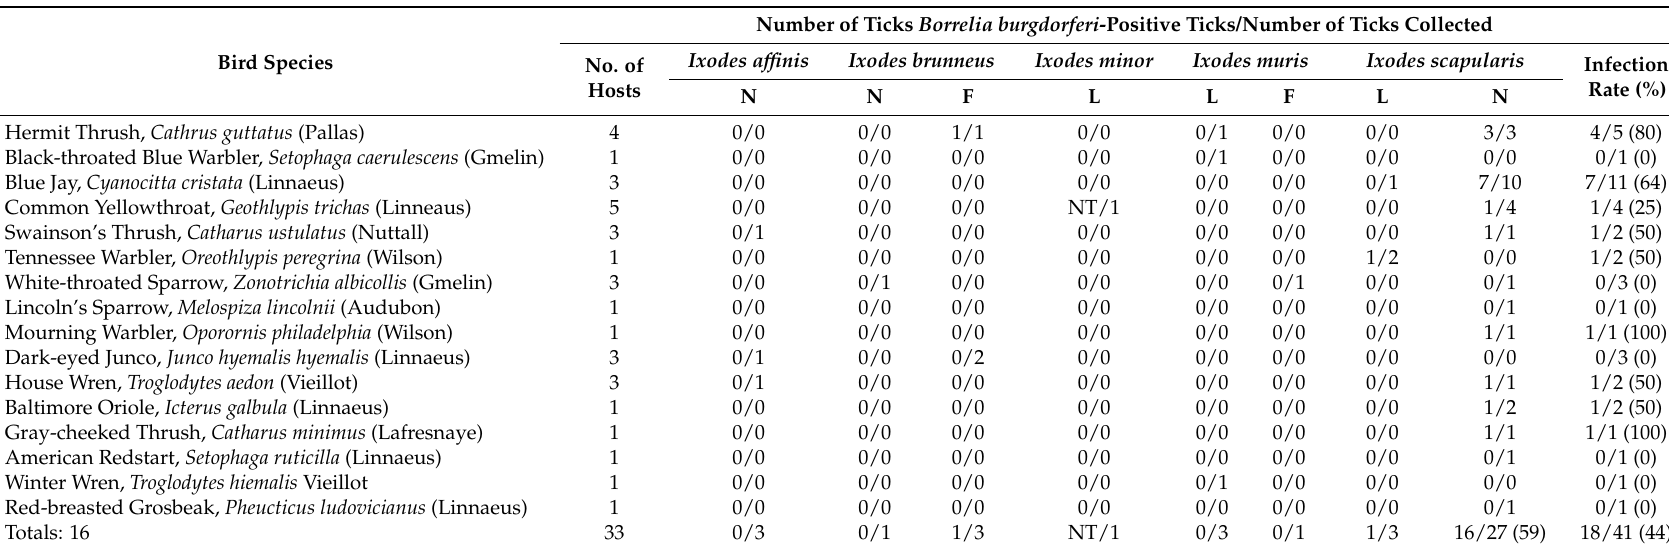
Table 4. Detection of Borrelia burgdorferi sensu lato in Ixodes ticks collected from avian hosts in the London-St.Thomas-Simcoe-Toronto, Ontario area, 2013–2016. Number of Ticks Borrelia burgdorferi -Positive Ticks/Number of Ticks Bird Species